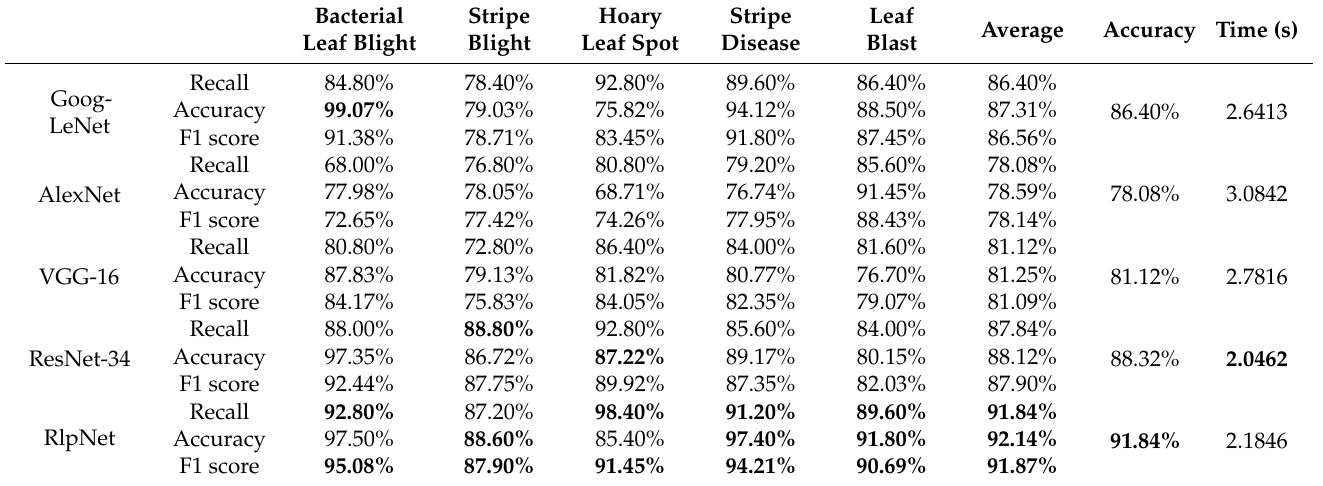
Table 2. Test results.